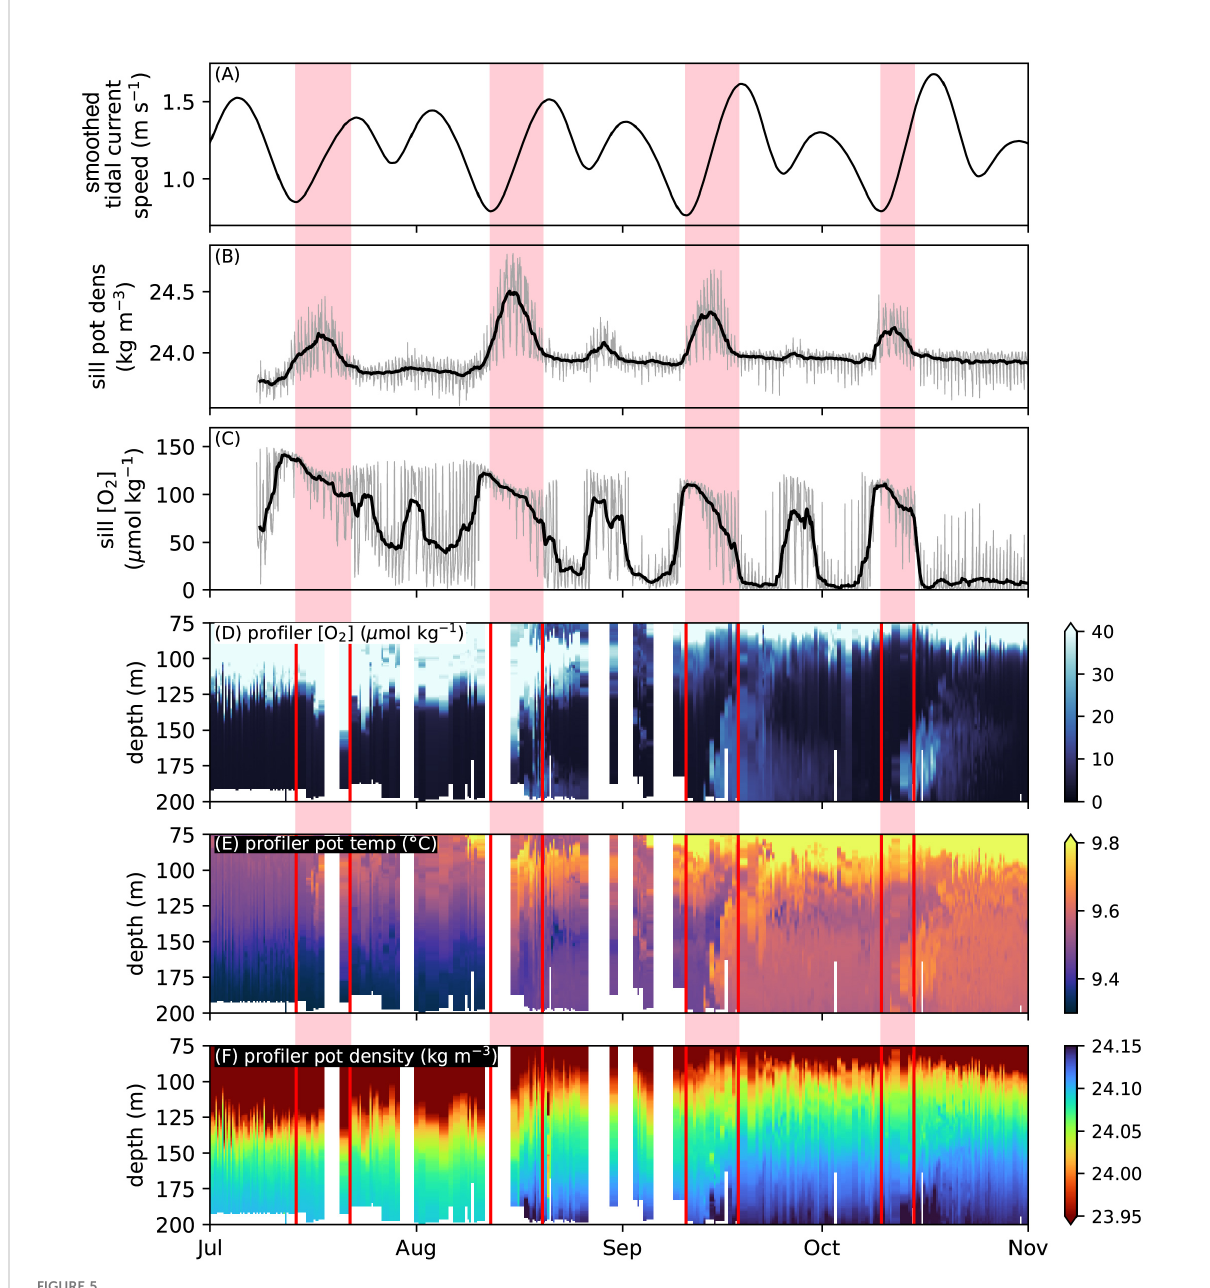
FIGURE 5 Overview of 2016 renewal season. (A) Smoothed tidal current speeds at Active Pass (m s -1 ). (B) Potential density ( s q kg m -3 ) at the sill mooring. (C) Oxygen concentration ( m mol kg -1 ) at the sill mooring. (B, C) Grey lines show 10-min frequency data. Black lines show 50-hr triangular fi lter. (D) Oxygen concentration ( m mol kg -1 ) at the pro fi ling mooring. (E) Potential temperature (°C) at the pro fi ling mooring. (F) Potential density ( s a kg m -1 ) at the pro fi ling mooring. (A-F) Pink bars/red lines indicate the renewal event from the minimum in smoothed tidal current speed in (A) to the approximate return of the sill mooring density to the baseline in (B) . (D-F) Only waters deeper than 75 m are